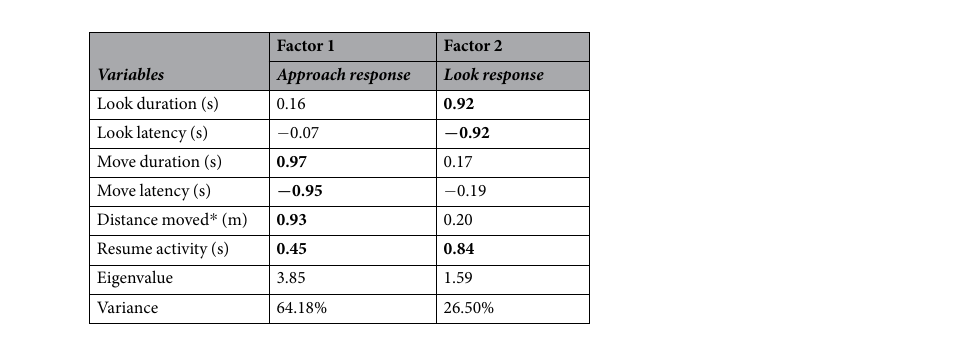
Table 1. Loadings from Factor Analysis. * Distance moved towards speaker ( not away